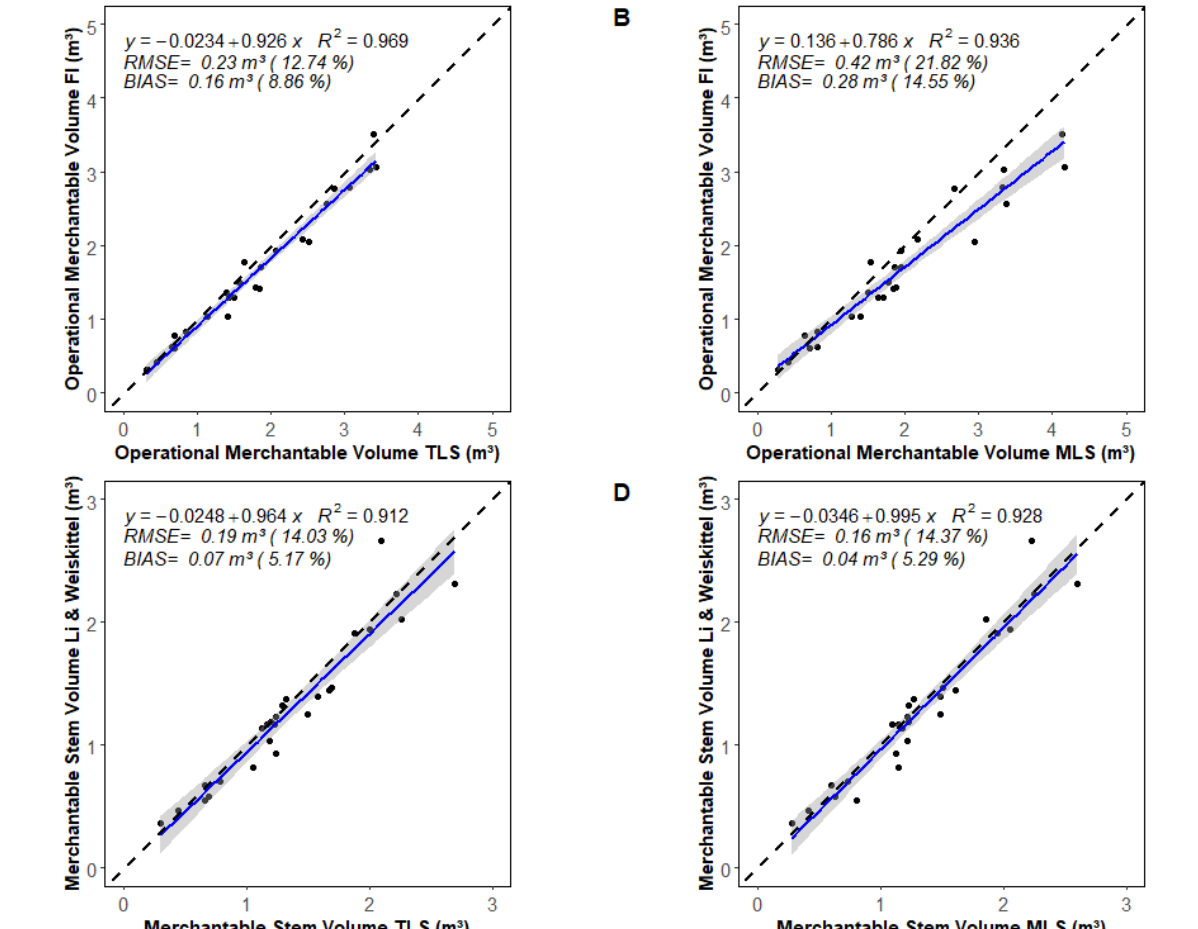
Figure 9. ( A , B ) Comparison of operational merchantable volume derived from the destructive field inventory (FI) (i.e., stem and branches with small end diameter outside bark (DOB) ≥ 8 cm and length ≥ 244 cm) with the QSM-derived value (i.e., branching order 0–3 with small end DOB ≥ 8 cm and length ≥ 244 cm) from ( A ) TLS and ( B ) MLS data. ( C , D ) Comparison of the merchantable stem volume derived from Li and Weiskittel’s taper model (i.e., main stem with small end DOB ≥ 8 cm) with the QSM-derived value of the stem (i.e., branching order 0 with small end DOB ≥ 8 cm) from ( C ) TLS and ( D ) MLS data. n = 26 trees. The blue line represents the linear regression. The grey zone is the 95% confidence band for predictions. The dashed black line represents the 1:1 line.